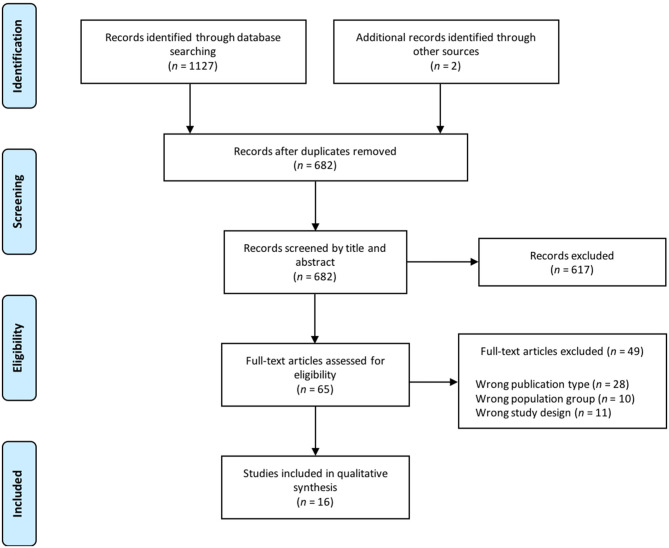
Flow chart article selection.